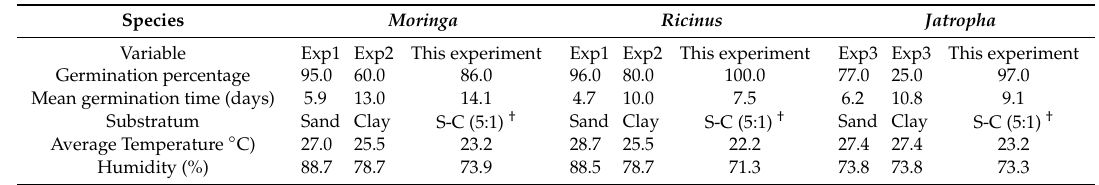
Table 1. Percentage and average germination days of Moringa oleifera , Jatropha curcas , and Ricinus communis obtained in this and previous experiments at the experimental